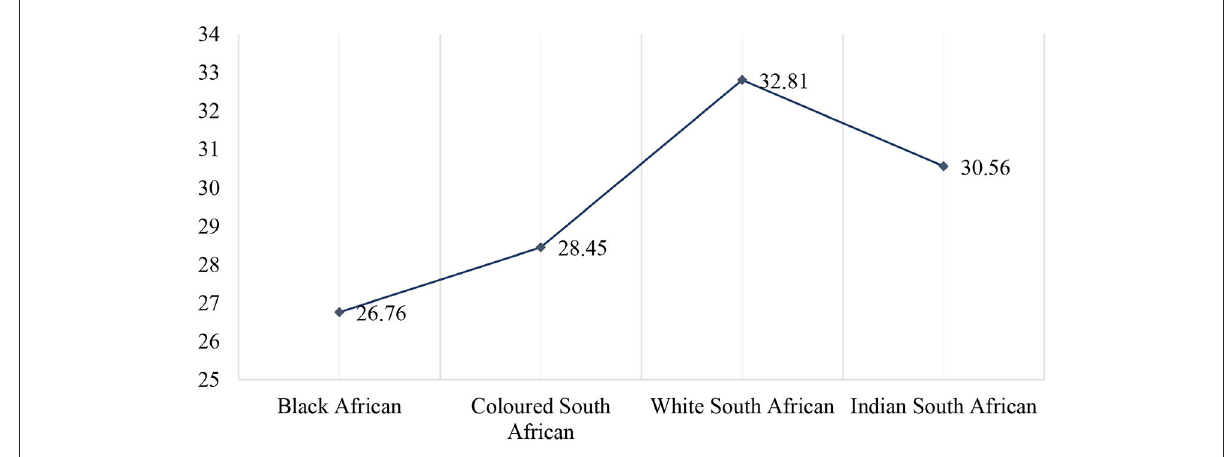
FIGURE3 Quality of life scores by racial identity.